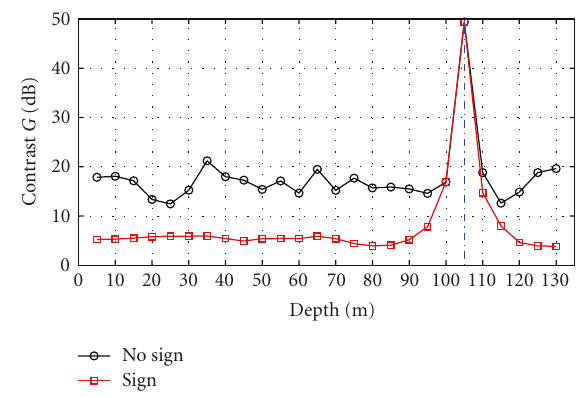
Figure 20: Contrast functions G for depth source localization by F - K approach. The results are given for methods: without mode signs (circles) and with mode signs (squares). The source is located at 105 m of depth. The vertical resolution is 5m.